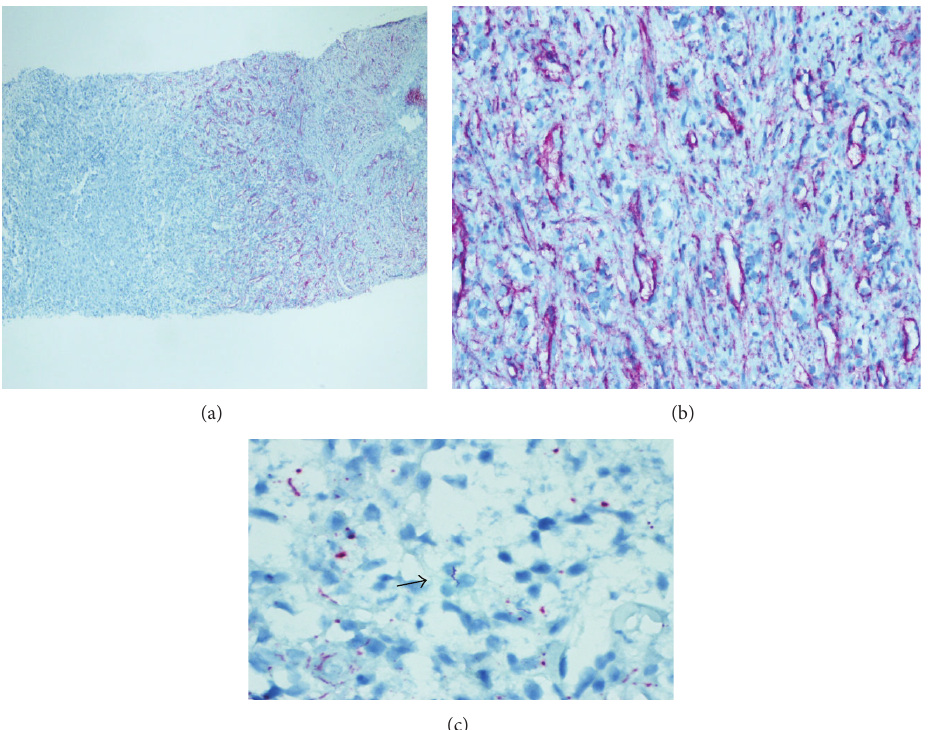
Figure 3: Histological findings: (a) IHC, 40X: scanning power view of liver core biopsy immunohistochemically stained for Treponema pallidum . Organisms are visible as red color and correspond to the fibrotic inflamed area seen on hematoxylin and eosin stain (H&E). T. pallidum , 40X. (b) IHC, 200X: intermediate power view shows spirochetes centered around blood vessels and infiltrating into sclerotic hepatic parenchyma. T. pallidum , 200X. (c) IHC, 600X: high power magnification of spirochete highlights the spiral morphology. T. pallidum , (black arrow)